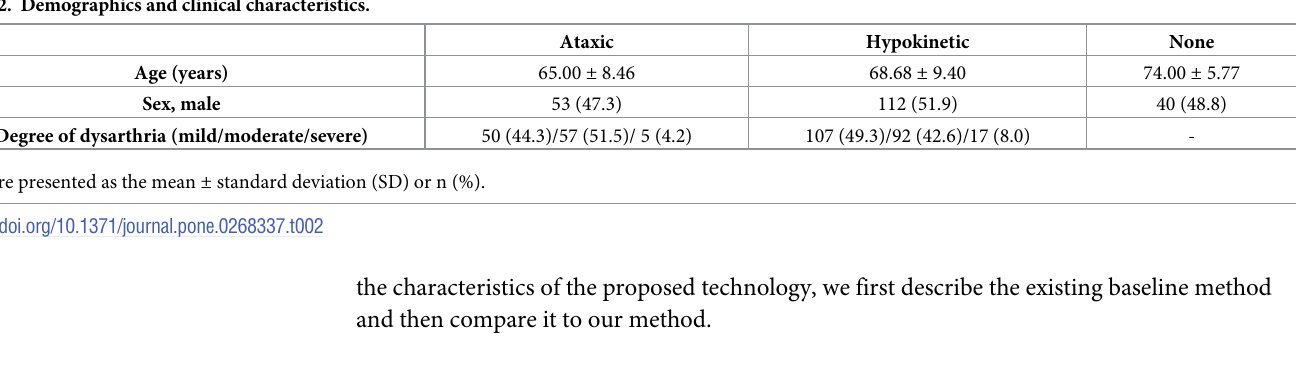
PLOS ONE | https://doi.org/10.1371/journal.pone.0268337 June 3,